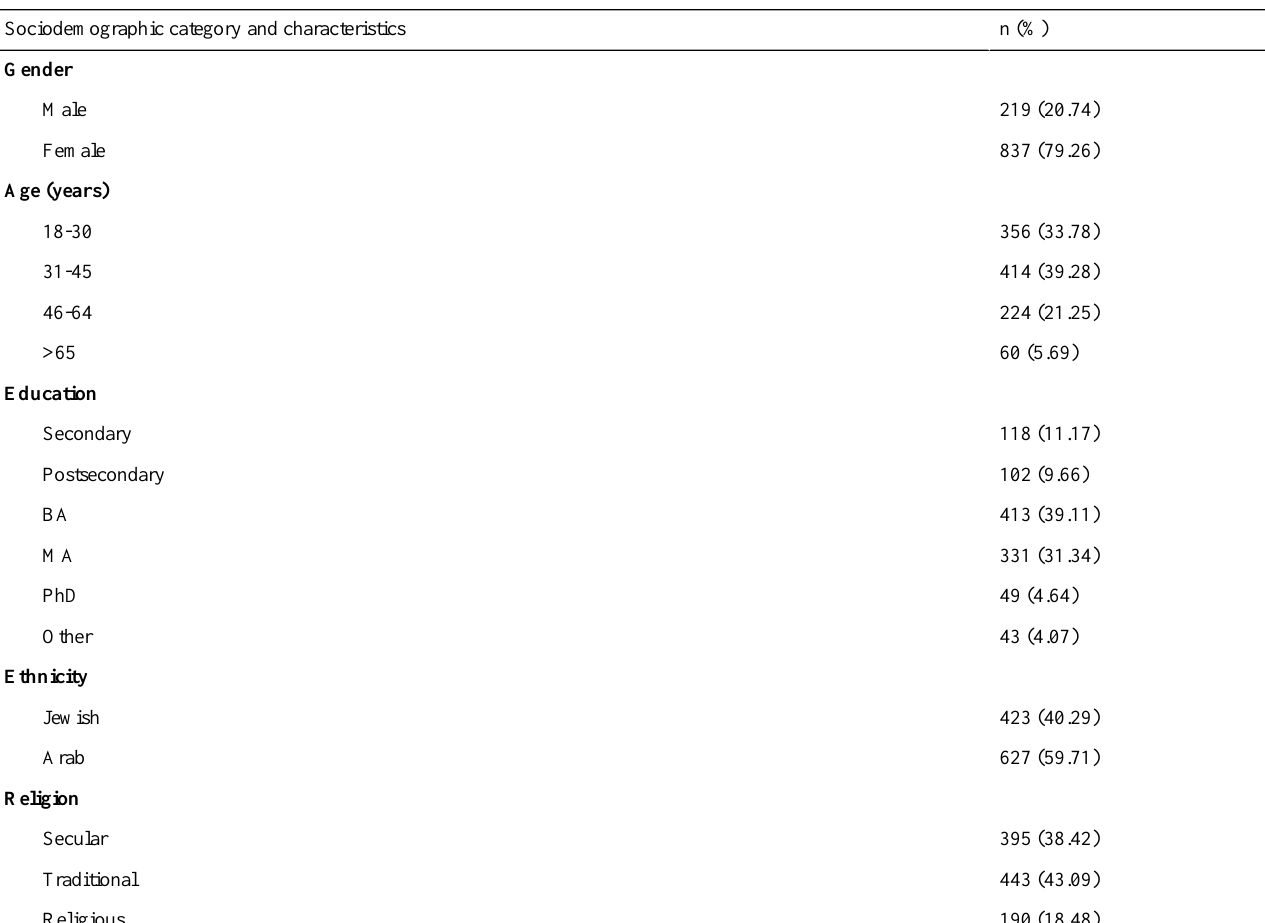
Table 1. Sociodemographic characteristics of the survey participants (N=1056).